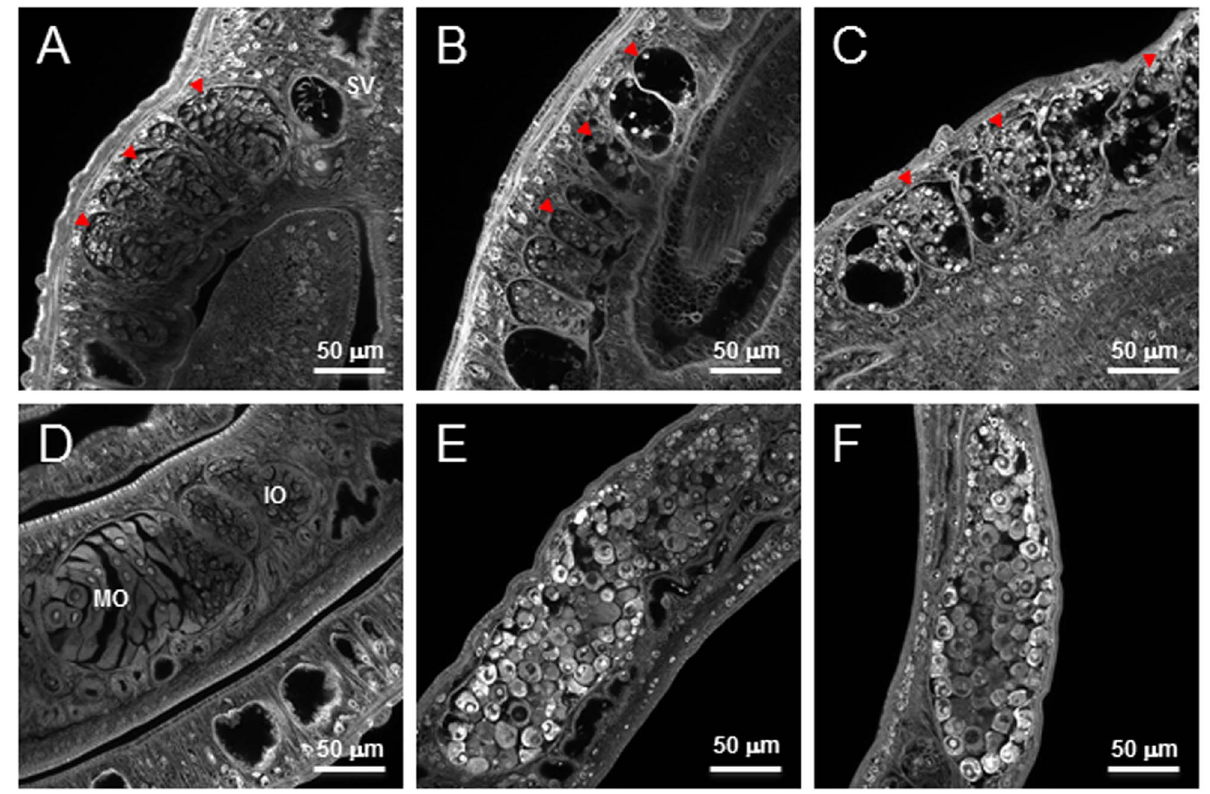
Figure 8. Freshly perfused adult couples were maintained in culture for 6 days and incubated with DMSO or with 10 m M and 20 m M of Salermide, then fixed and stained with hydrochloric carmine. Male worms treated with 10 m M (B) or 20 m M (C) Salermide show a drastic reduction in numbers of germinal cells in the testes (red arrows) compared to the control (A). The seminal vesicle is labeled (SV) on the control (A). In females treated with 10 m M (E) or 20 m M (F) Salermide we observed a dramatic disorganization of the ovary, where immature oocytes were less abundant and the mature cells seemed to invade the whole ovary compared to the control (D). The anterior part of the ovary, containing immature oocytes (IO) and the posterior part, containing mature oocytes (MO) are